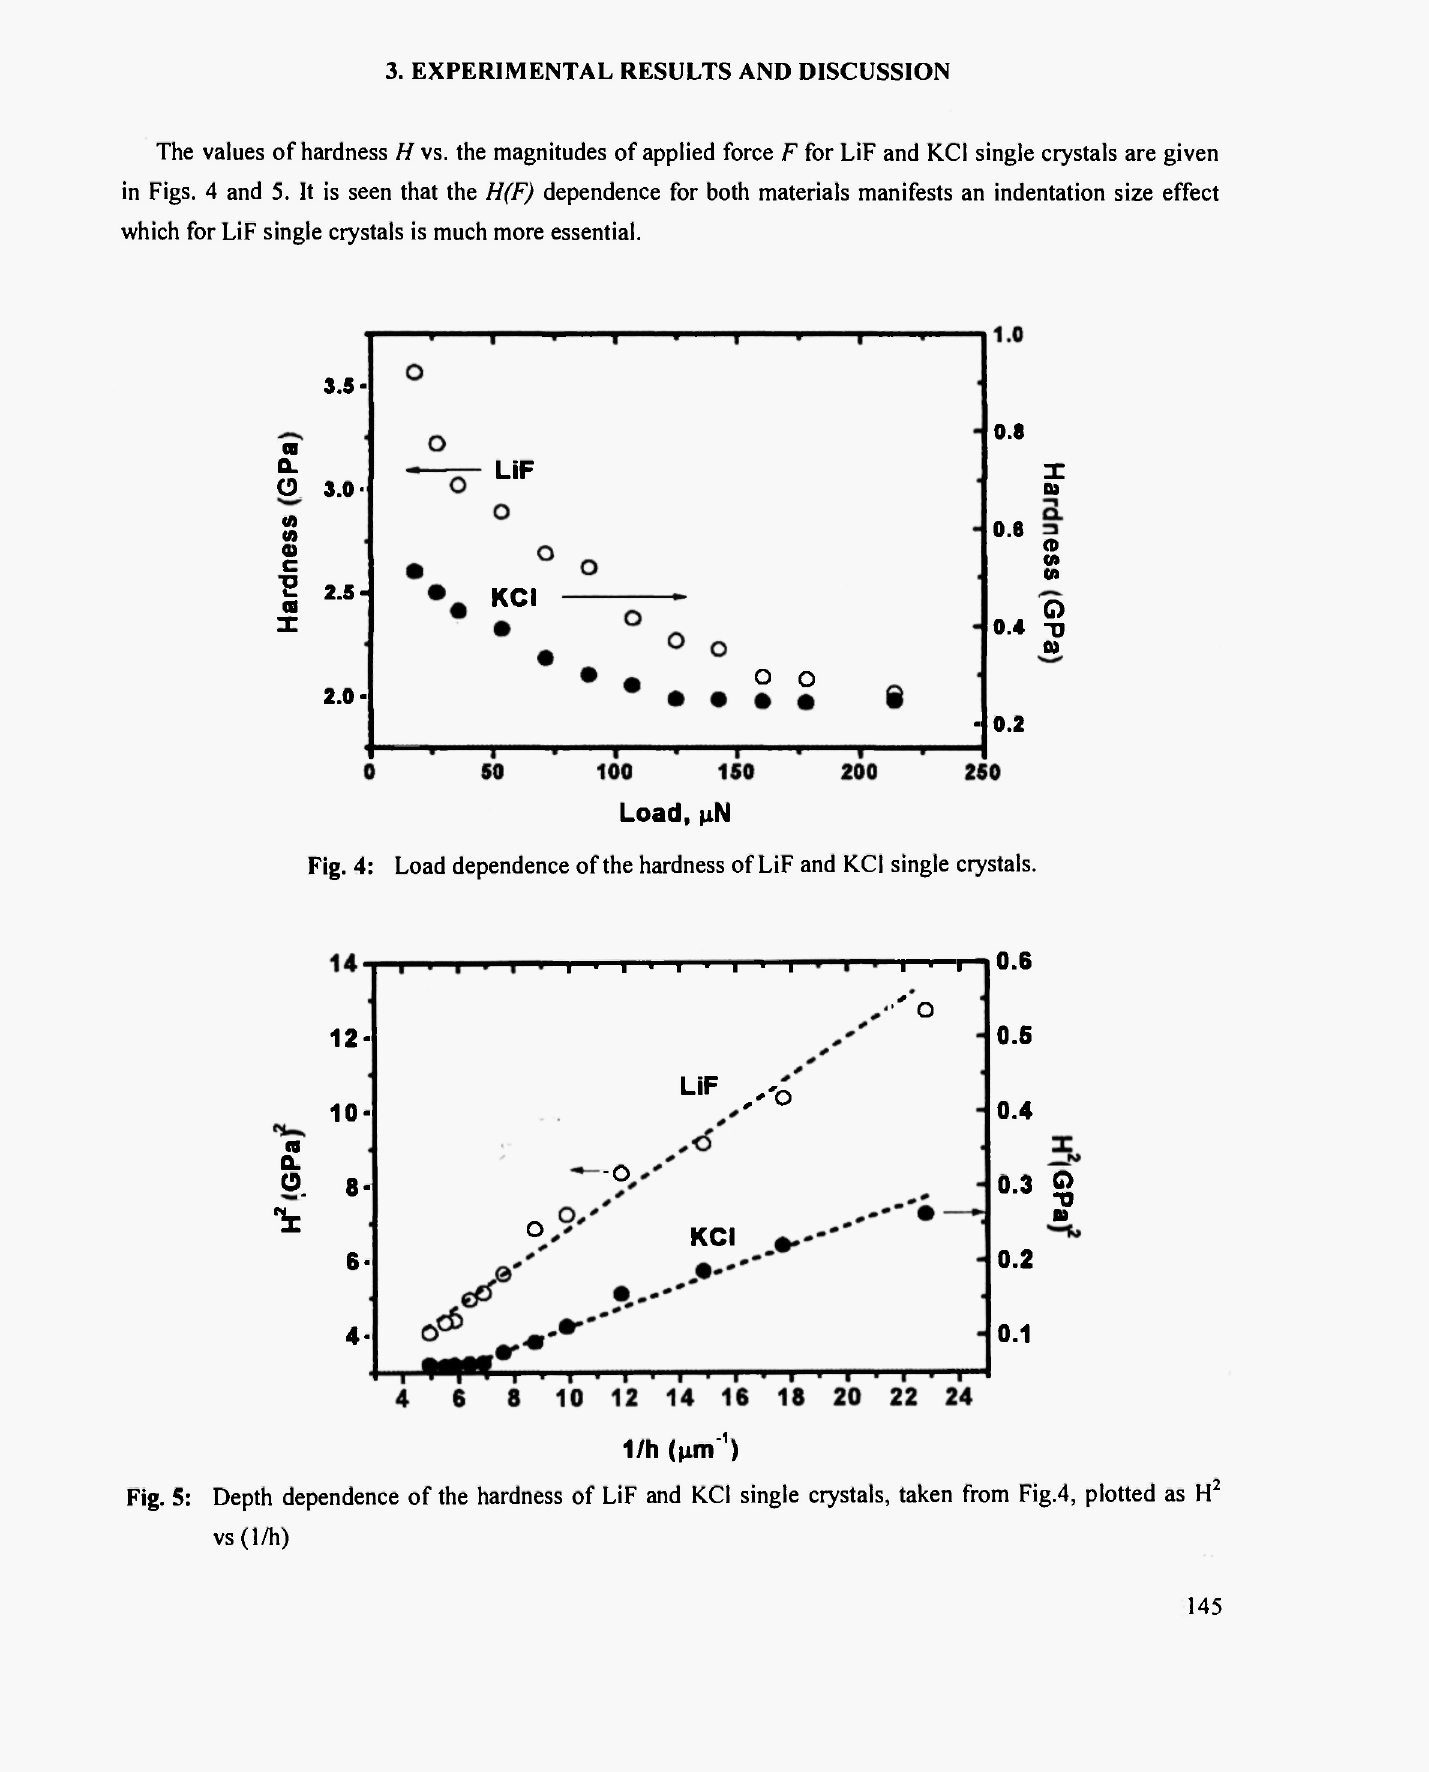
Fig. 4: Load dependence of the hardness of LiF and KCl single crystals.